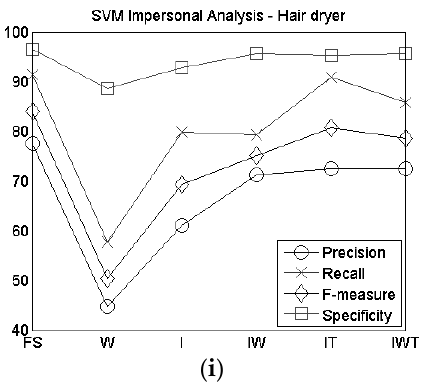
Figure 6. Precision, recall and specificity of SVM impersonal analysis for ( a ) Hand gesture; ( b ) Glass gesture; ( c ) Fork gesture; ( d ) Spoon gesture; ( e ) Cup gesture; (f ) Phone gesture; ( g ) Toothbrush gesture; ( h ) Hairbrush gesture; ( i ) Hair dryer gesture.